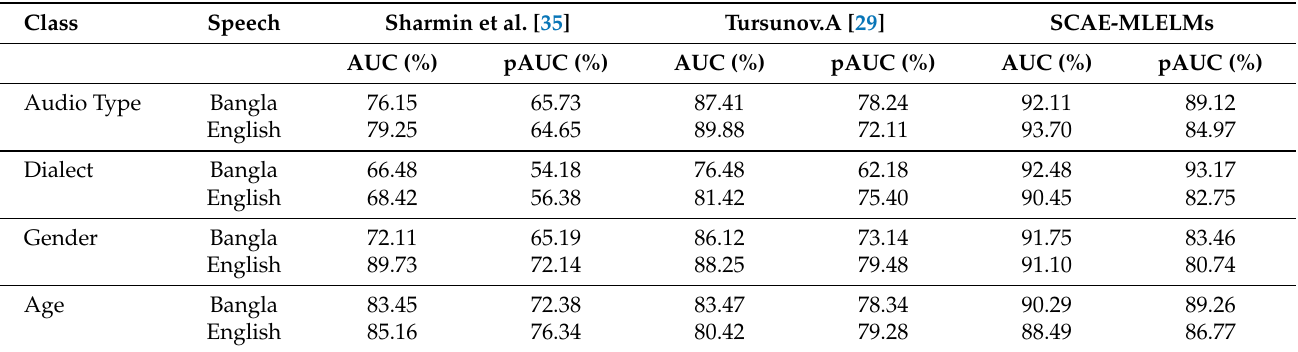
Table 11. Performance Results of existing methods; Sharmin et al. [35]: Deep CNN, and Tursunov [29]; Multi-attention module CNN model for MFECs data